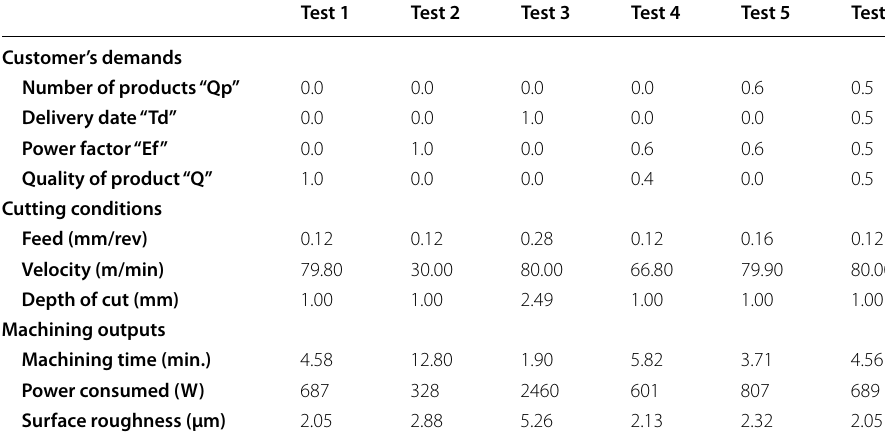
Table 8 Experimental results for